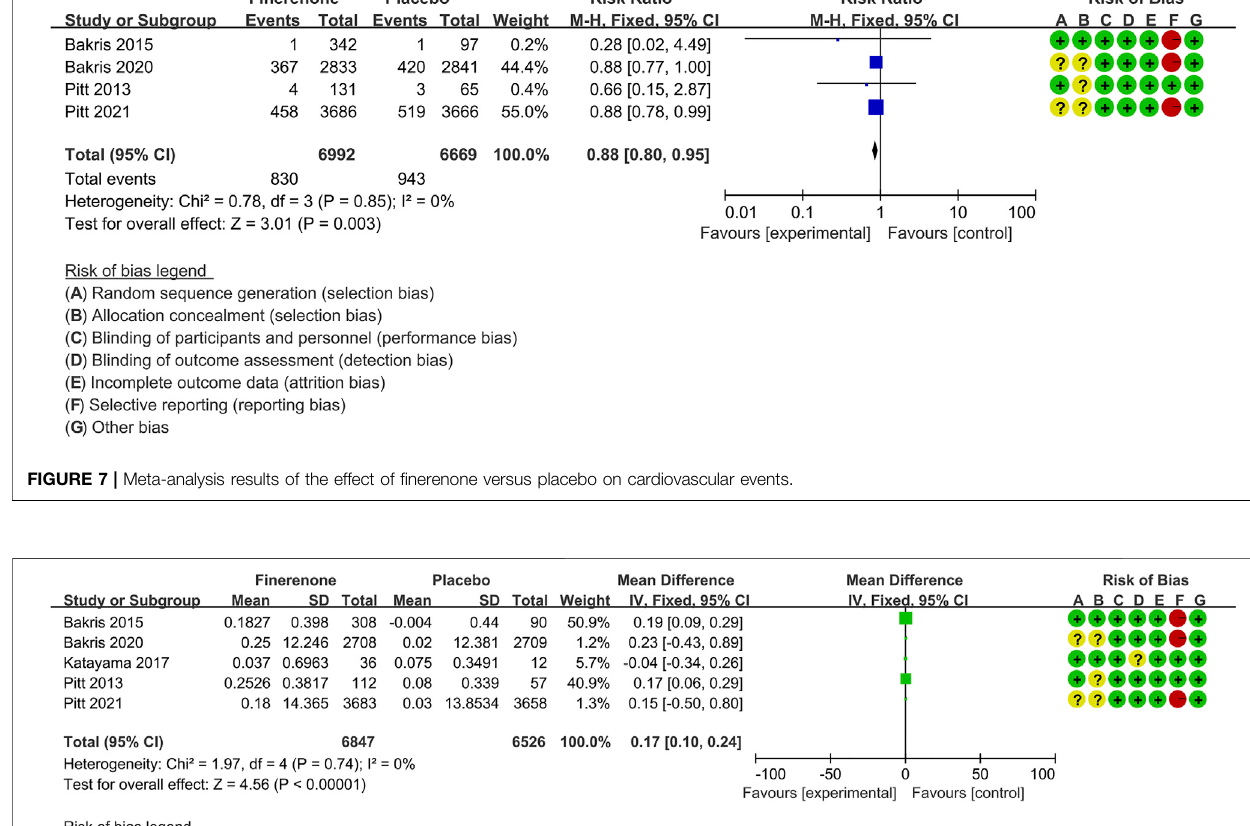
signi fi cantly higher in the fi nerenone than in placebo groups [RR 2.03 (95% CI 1.83, 2.26), p < 0.00001]. Adverse Events